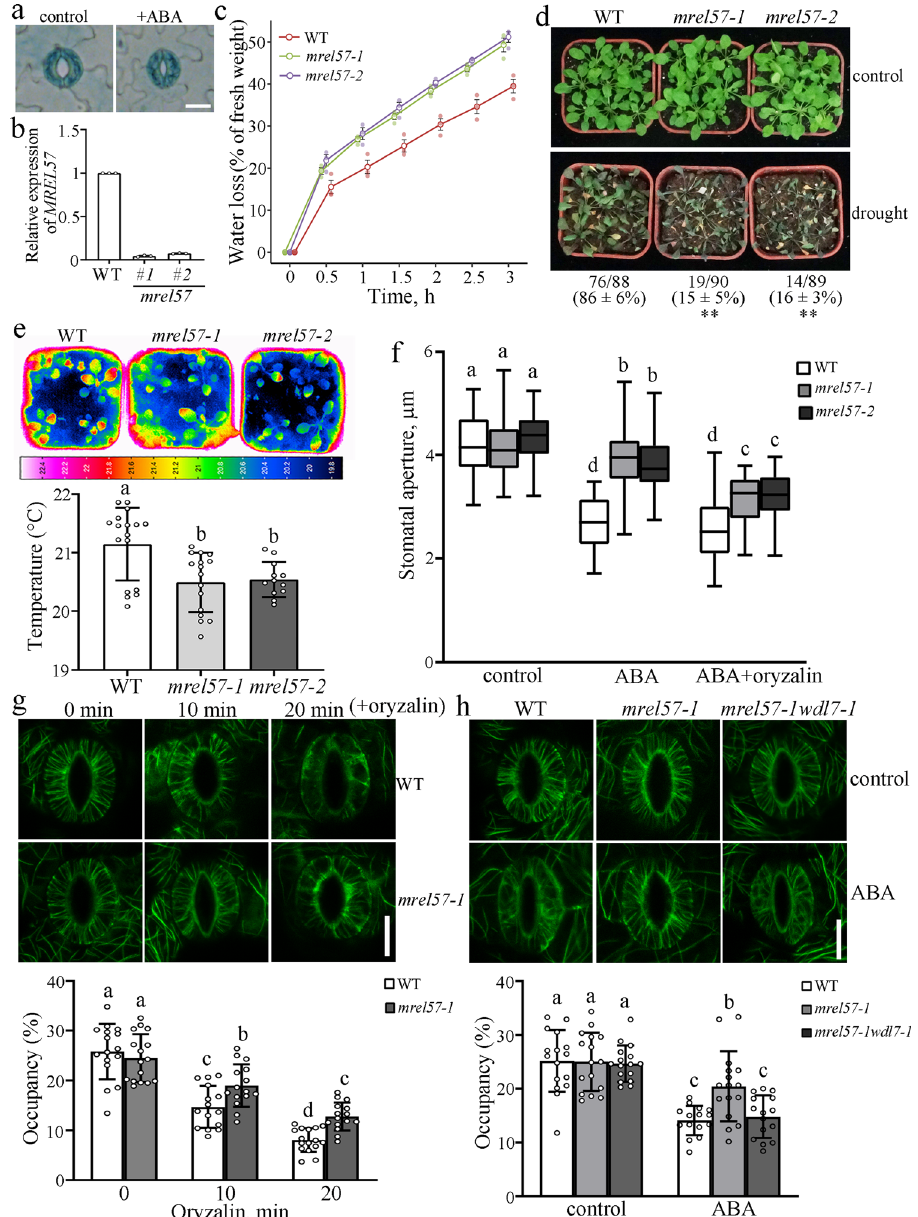
Fig. 6 MREL57 destabilizes microtubules and positively regulates stomatal closure in response to ABA. a Detached rosette leaves from Pro MREL57 :GUS transgenic seedlings were incubated in opening buffer for 2h and then treated with or without 10 μ M ABA for 2h. The epidermal strips were peeled from the rosette leaves and GUS staining was performed. The experiment repeated three times with similar results. Scale bar = 10 μ m. b MREL57 expression was detected by quantitative real-time RT-PCR in WT, mrel57-1 , and mrel57-2 mutant seedlings. The experiment was repeated three times as different biological replicates. Error bars indicate standard deviation. c Fresh weights of detached leaves of seedlings from WT, mrel57-1 , and mrel57-2 were measured every 30min for a total of 3 h. The experiment was repeated three times with independent treatments. d Drought phenotypes in the wildtype, mrel57-1 , and mrel57-2 in soil. Three-week-old seedlings were subjected to drought stress by withholding water for 2 weeks before being photographed. Values represent mean ± SD for three independent experiments. Two-tailed Student ’ s t test. ** p < 0.01. e Infrared thermography of seedlings from WT, mrel57-1 , and mrel57-2 . Leaf temperature was measured using infrared camera software. The experiment was repeated three times with independent treatments. Error bars indicate standard deviation. Data represent mean ± standard deviation (SD) values. Different letters represent signi fi cant differences at p <0.01 (one-way ANOVA). f Detached rosette leaves from WT, mrel57-1 , and mrel57-2 were incubated in opening buffer for 2h and then treated with 10 μ M ABA with or without oryzalin. The box and whiskers plots represent minimum and maximum values. The line in the box indicates the median value and the boundaries demonstrate the 25th percentile (upper) and the 75th percentile (lower). Different letters represent signi fi cant differences at p <0.01 (one-way ANOVA). The experiment was repeated three times as different biological replicates with a minimum of 100 stomatal pores. g Cortical microtubules in guard cells from WT and mrel57-1 seedlings treated with 5 μ M oryzalin for the indicated times. Scale bar = 10 μ m. The graph shows the densities of microtubules. Data represent mean ± standard deviation (SD) values from three independent experiments with a minimum of 15 cells each. h Cortical microtubules in guard cells from WT, mrel57-1 mutant, and mrel57-1wdl7-1 double mutant seedlings treated with 10 μ M ABA for 40 min. Scale bar = 10 μ m. The graph shows the densities of microtubules. Data represent mean ± standard deviation (SD) values from three independent experiments with a minimum of 15 cells each.